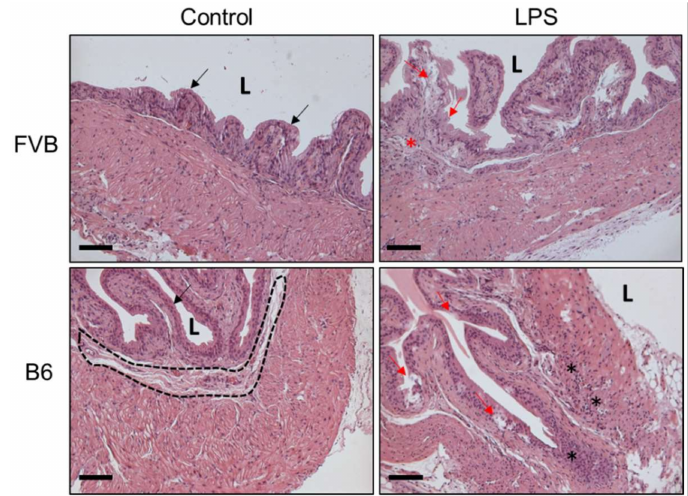
Figure 4. Bladder H&E staining of control group and LPS-induced group of both FVB and B6 mice. Black arrow indicates the urothelium of bladder. Black dotted circle shows the interstitial layer. Red arrow indicates the damaged urothelium of bladder after LPS-induced IC. Black star shows the leukocyte infiltration site. Red star shows the edema site. Lumen = L. Scale bar of 100 µ m.